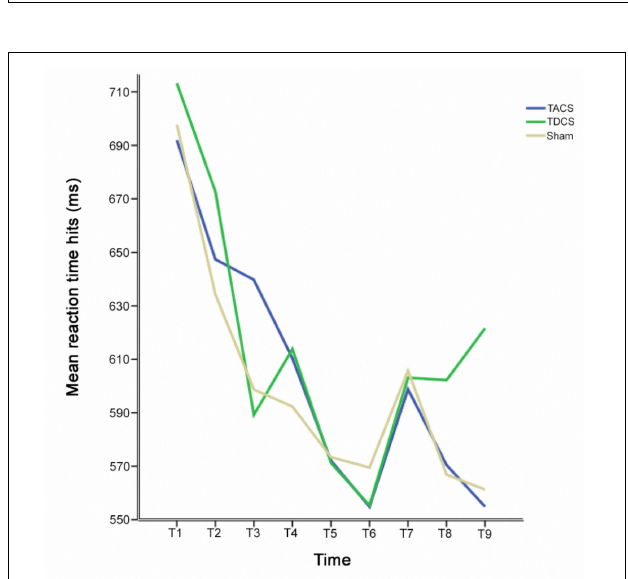
FIGURE 3 | Mean reaction times for hits before, during, and after stimulation at each assessment time for each stimulation type.